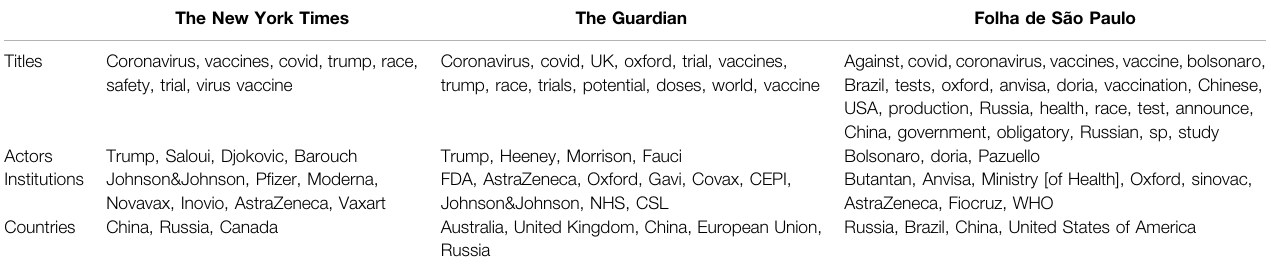
TABLE2| Mostfrequentwordsinthetitles;andmostfrequentactors,institutions,andcountriesinthetextsof TheNewYorkTimes , TheGuardian ,and FolhadeSãoPaulo